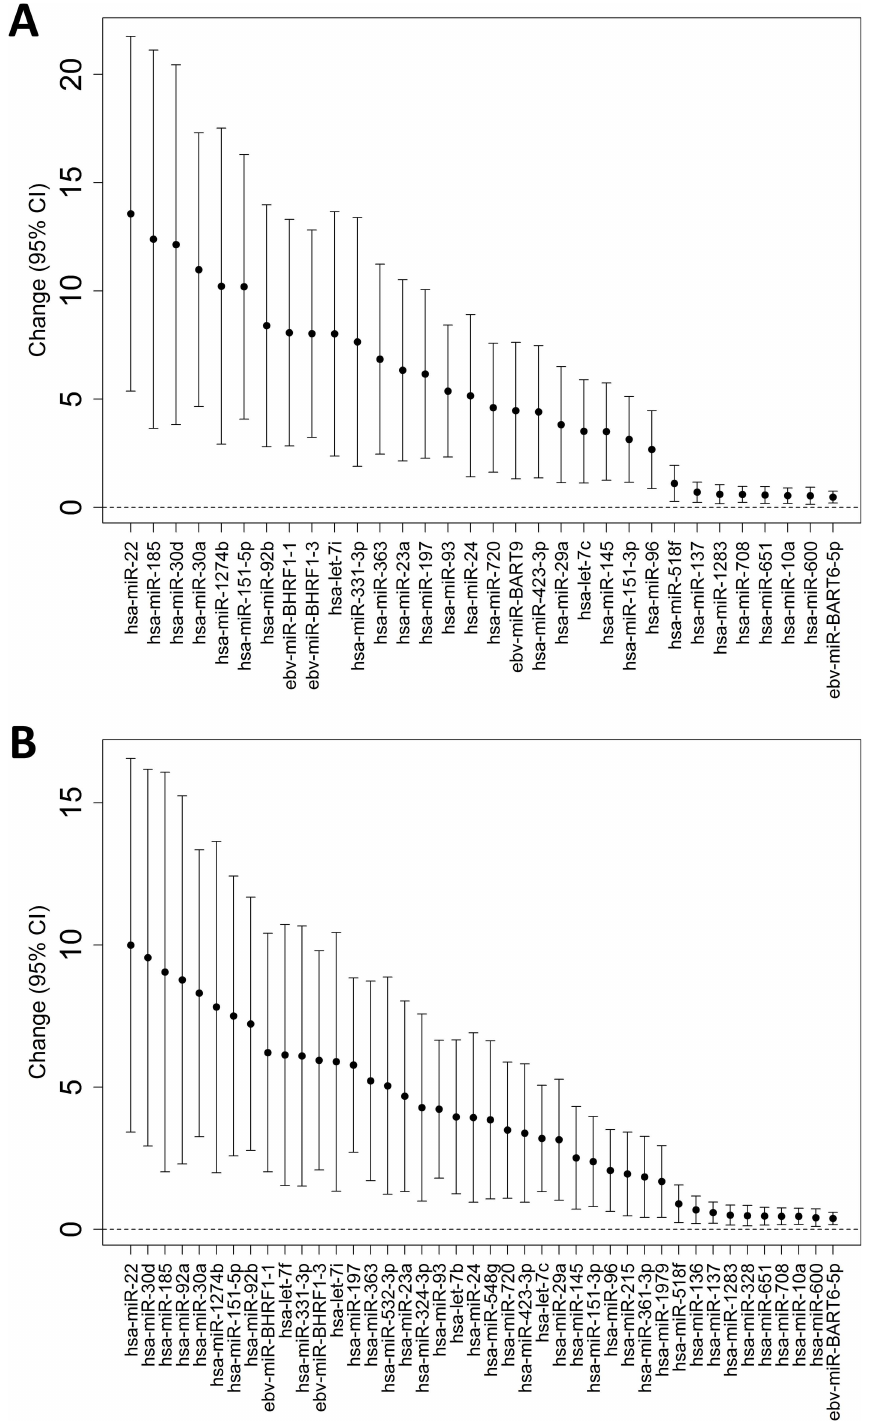
Fig 1. miRNAs associated with pre-work blood pressurechanges in pooled analysis. Significant miRNAs associatedwith (A) SBP, and (B) MAP at FDR < 5%in the pooledanalysis.